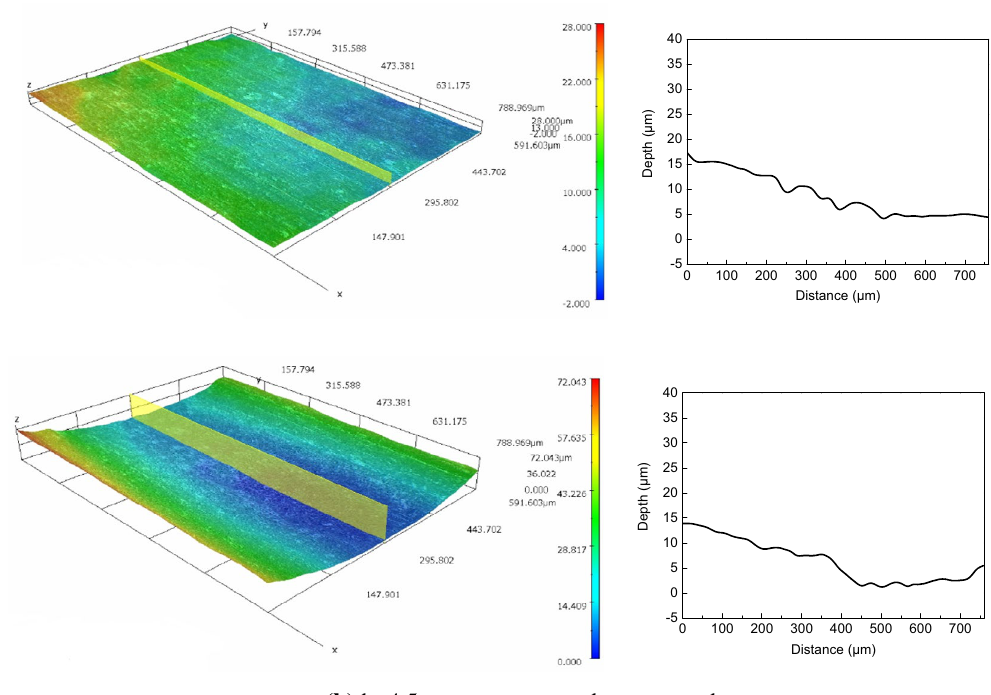
Figure 11. 3D surface morphology and profile of the substrate corrosion under static liquid